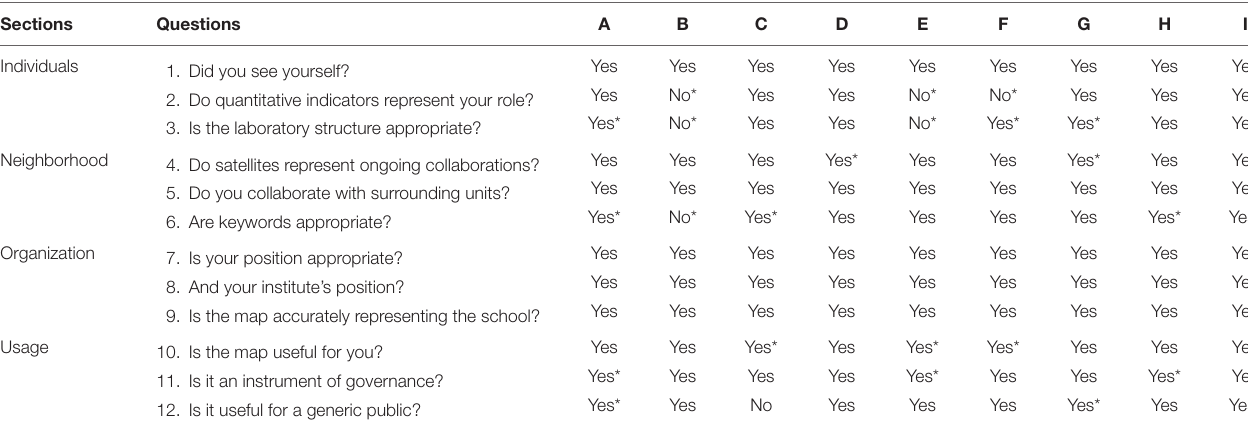
Table 3 | Results of the interviews.